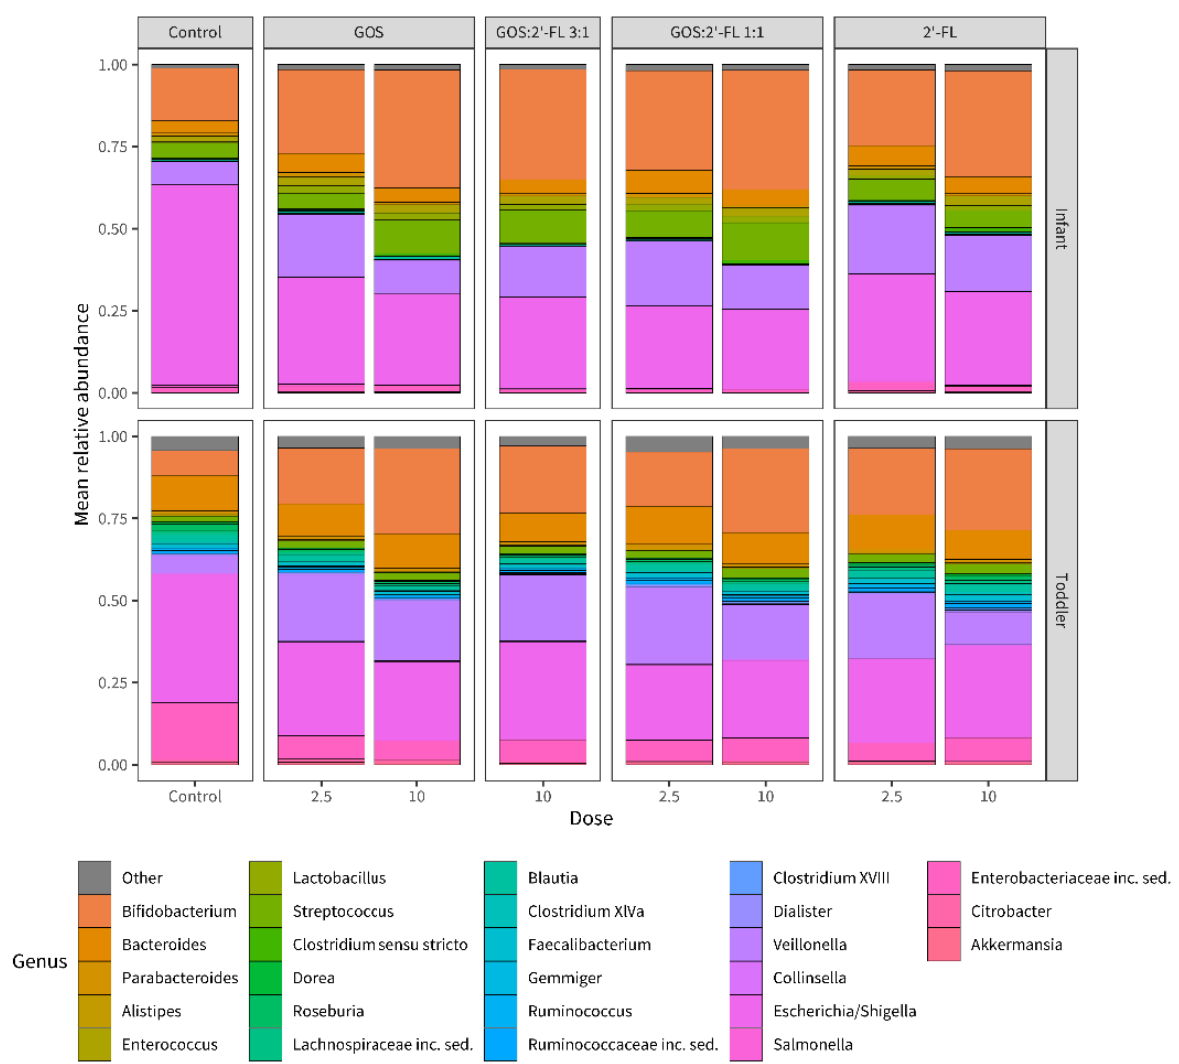
Figure 2. Relative abundance bar chart showing the top 26 abundant bacterial genera as determined by 16S rRNA gene amplicon sequencing. Results shown are from samples of the micro-Matrix bioreactor batch fermentation experiments after 6 h of fermentation with (GOS, 2′ -FL, and mixtures thereof, as indicated in the figure), or without oligosaccharides (medium control), from the infant (upper bars) and toddler (lower bars) populations. The values on the x-axis represent the final concentration of oligosaccharides (2.5 and 10 g/L). The ‘other’ group includes bacterial genera accounting each for less than 1.79% and 3.79% of the reads for infant and toddler samples, respectively. Each bar represents the mean of the 6 replicates run for each condition.